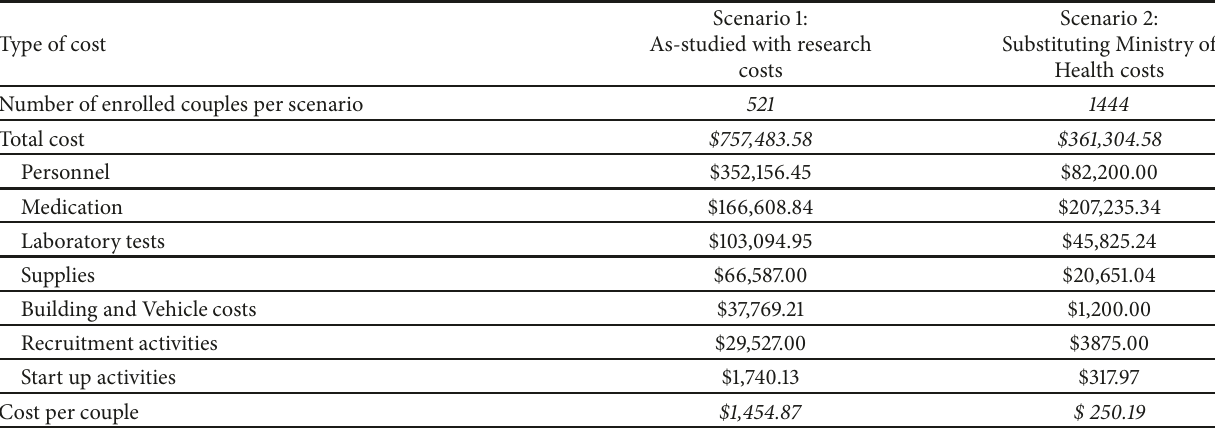
Table 2: Annual cost (2015 USD) of delivering integrated PrEP and ART to HIV serodiscordant